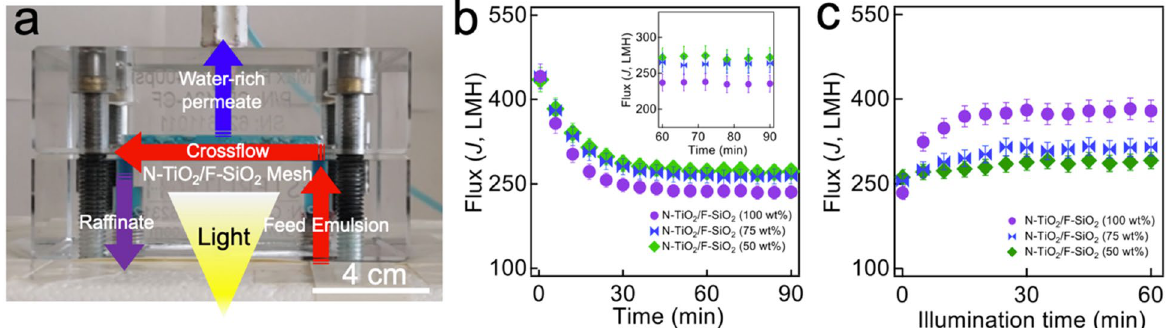
Figure 2. Evolution of water-rich permeate flux during continuous cross-flow separation of oil–water emulsion upon visible light illumination. (a) Photograph of the apparatus that enables continuous cross-flow separation of an oil–water mixture and in situ photocatalysis. (water is dyed blue and oil is dyed red). (b) The measured flux values ( J ) of the water-rich permeate through the mesh coated with various N-TiO 2 concentrations (50 wt%, 75 wt%, and 100 wt%) of N-TiO 2 /F-SiO 2 mixture during separation of SDS-stabilized n-hexadecane-in-water emulsion (1:9 n-hexadecane:water volumetric ratio). The inset shows zoomed-in flux values in the time interval of 60–90 min. (c) The measured water-rich permeate flux values ( J ) while being illuminated by visible light ( I ≈ 198 mW cm −2